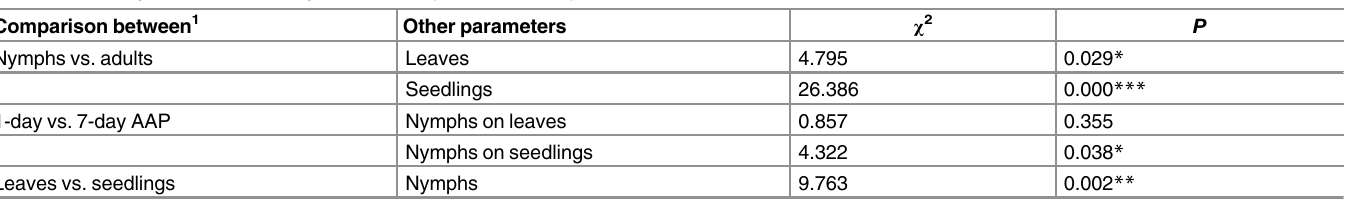
Table 7. χ 2 analysis of inoculativity test results (data in Table 6). Comparison between